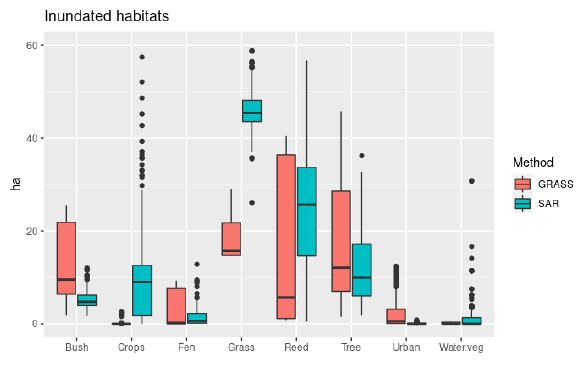
Figure 4. Differences in the extent of the flooded habitats at Bolle di Magadino (CH) calculated with two methods: filling the area around the lake according to water level (GRASS) and from remote sensing observation Sentinel-1 (SAR). All differences in mean were statistically significant (p < 0.05)